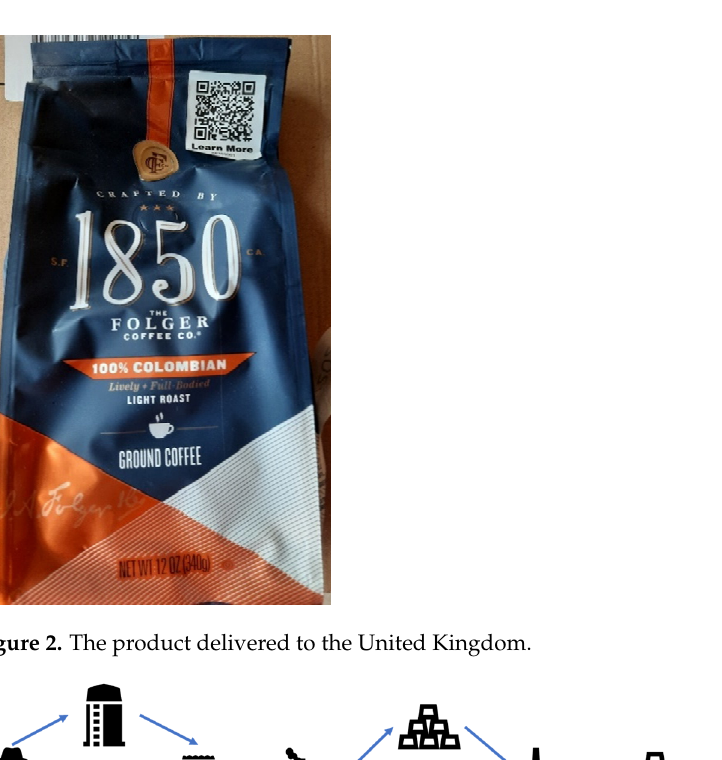
Figure 2. The product delivered to the United Kingdom.